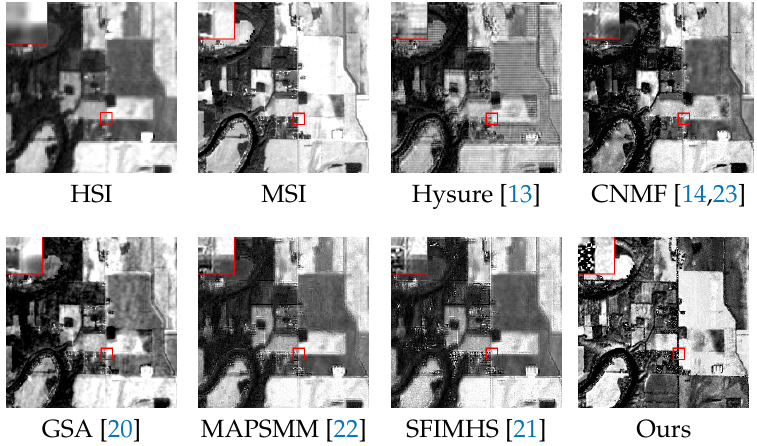
Figure 4. The fusion results of the compared methods on the real dataset